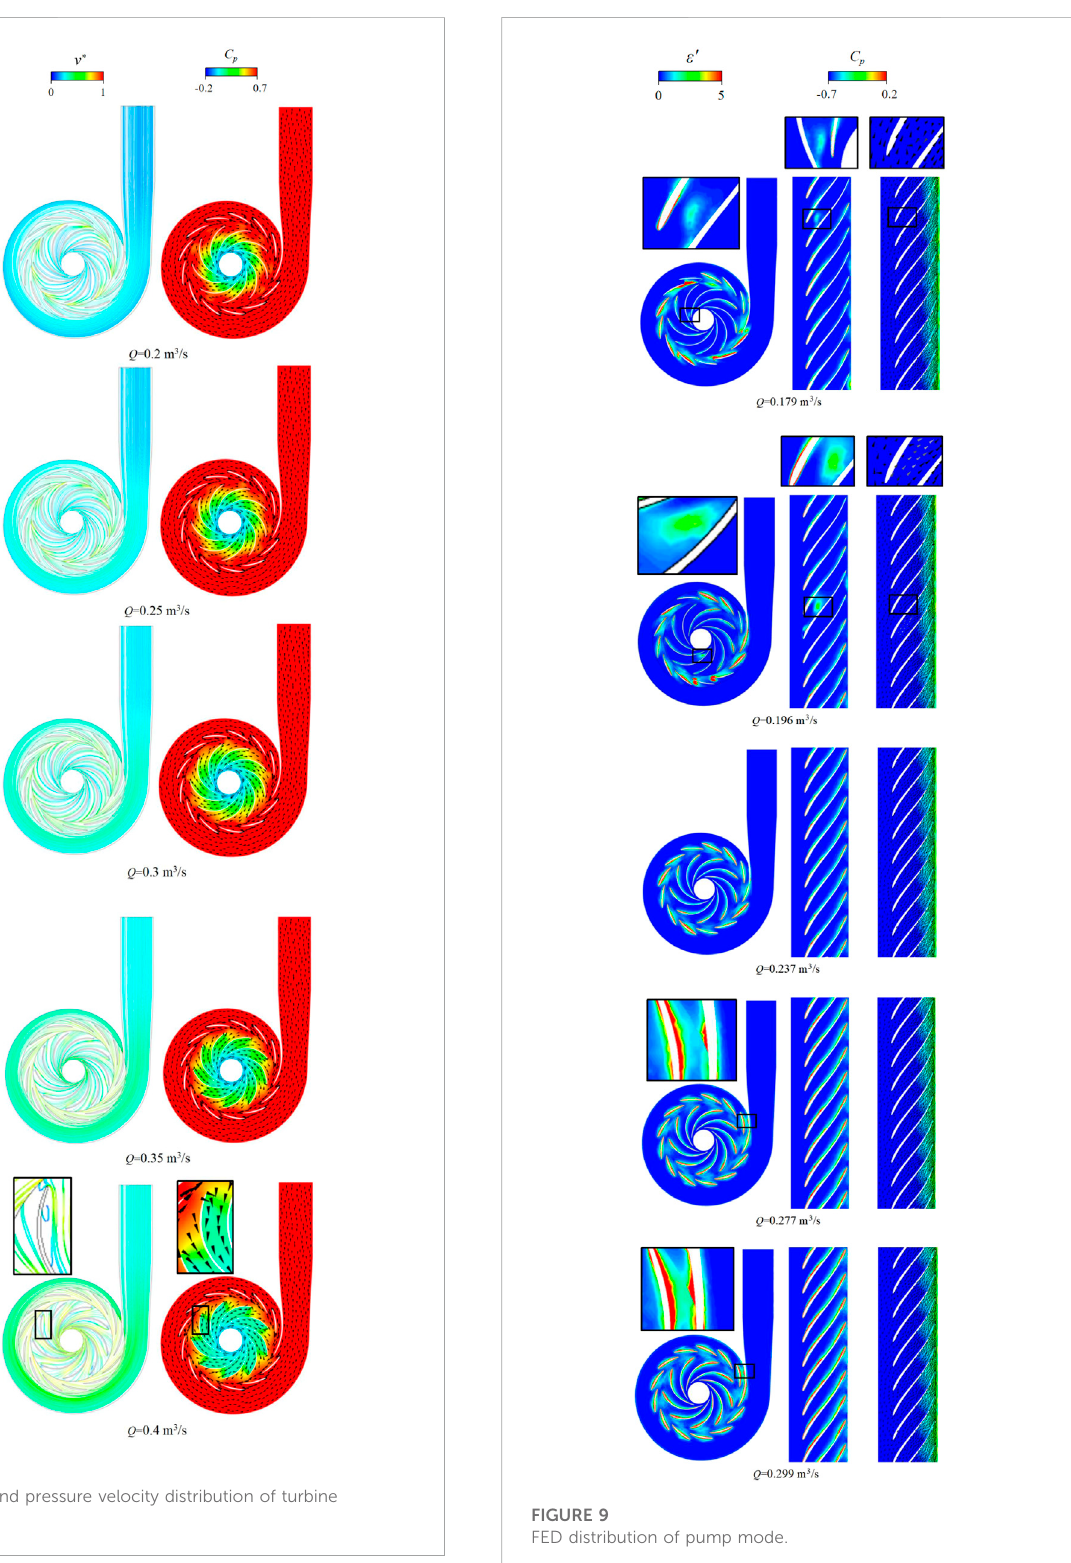
FED distribution of pump